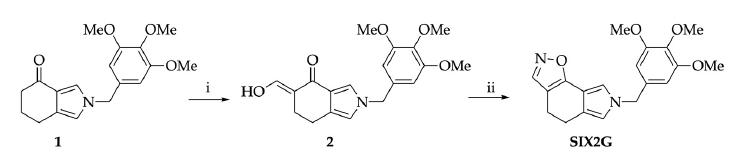
Figure 1. Reagents and conditions for SIX2G chemical synthesis. ( i ) t-BuOK, toluene, 0 ◦ C to RT, 2 h then HCOOEt, RT, 24 h, 64%; ( ii ) NH2OH · HCl, ethanol, reflux, 50 min,